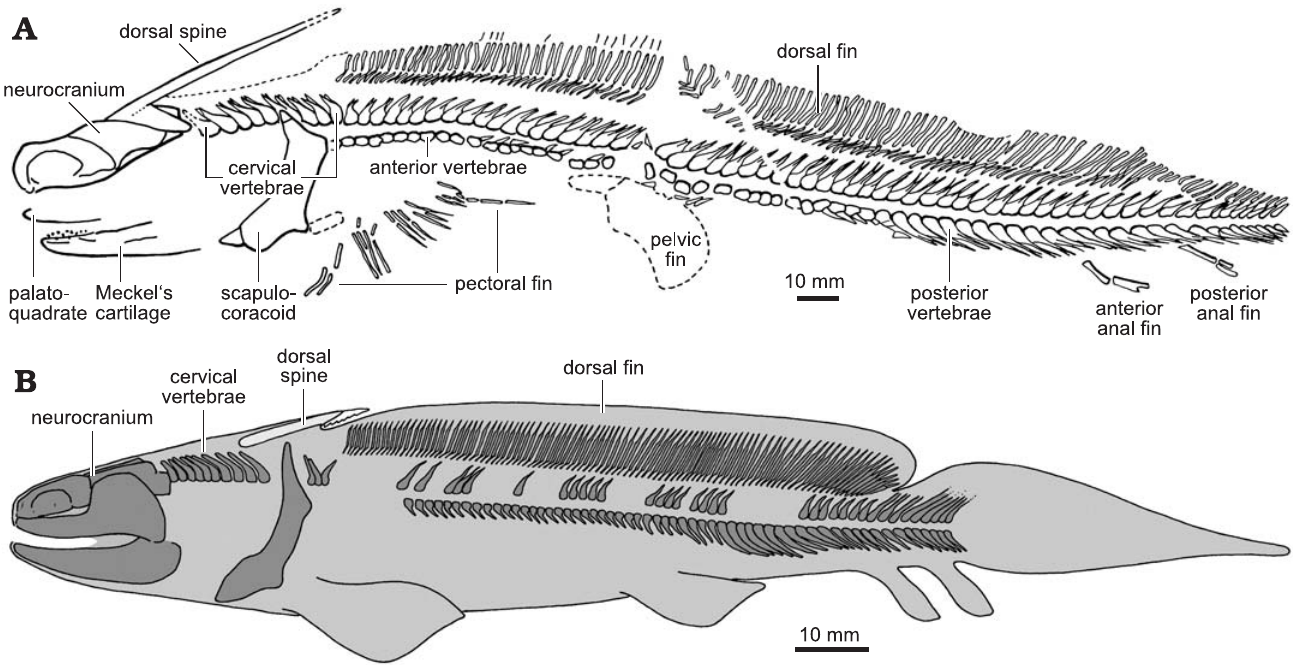
Fig. 2. Juvenile Orthacanthus platypternus , Stephanian B (Upper Carboniferous) of Hamilton, USA ( A ) compared to juvenile of O. bohemicus , Westphalian D (Upper Carboniferous) of Bohemia, Czech Republic ( B ), showing the relative position of the dorsal spine. A, modified from Zidek (1993b: fig. 1); B, modified from Soler-Gijón (2004: fig.